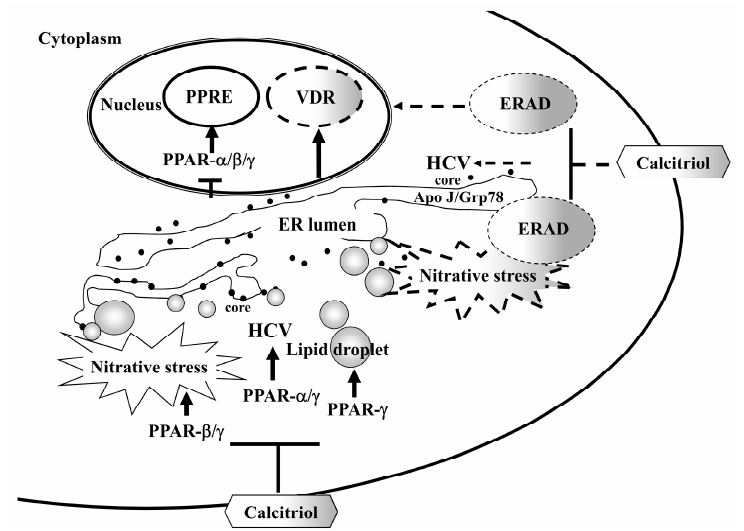
Figure 8. A schematic model of the involvement of PPAR and ERAD in calcitriol-mediated HCV suppression (T-bar). Calcitriol activated VDR but blocked PPAR- α / β / γ activity, meanwhile, it regulated the pathogenicity of HCV, e.g., inhibition of viral infection via PPAR- α / γ , relief of nitrative stress via PPAR- β / γ and reduction of lipid accumulation via PPAR- γ (solid arrow). Alternatively, calcitriol may regulate apoJ and Grp78 through ERAD pathway, which participate in calcitriol-mediated HCV suppression (dotted arrow).